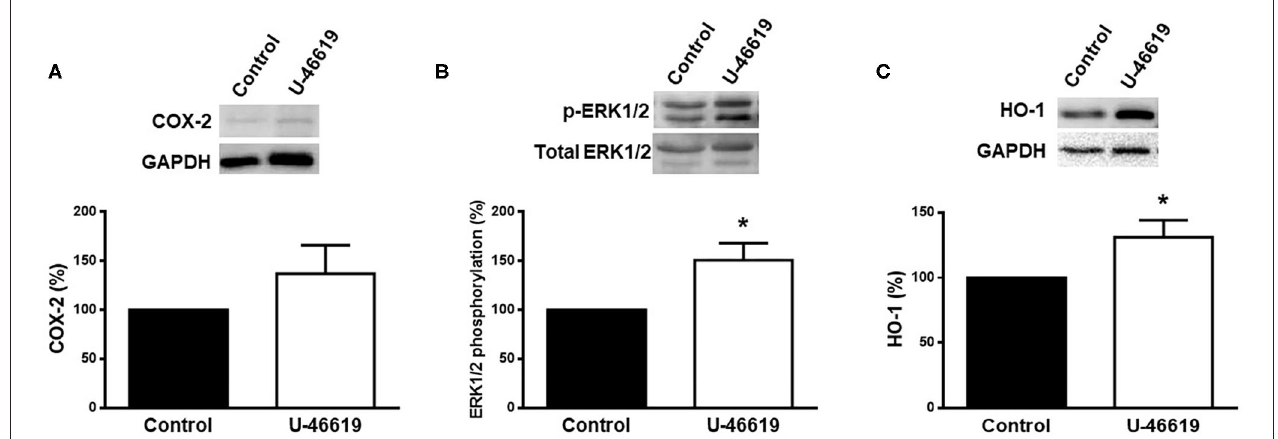
FIGURE 3 | Representative western blot and densitometric analysis for the expression of COX-2, p-ERK1/2, and HO-1 protein in aortic segments of male rat in the absence (control) or presence of U-46619 (1nM). Results (means ± SEM) are expressed as the relative percentage of the ratio between the signal for COX-2 or HO-1 protein and the signal for GAPDH; the signal for p-ERK1/2 was corrected to the corresponding total ERK1/2 signal. Number of animals: 3. * p < 0.05 compared with control